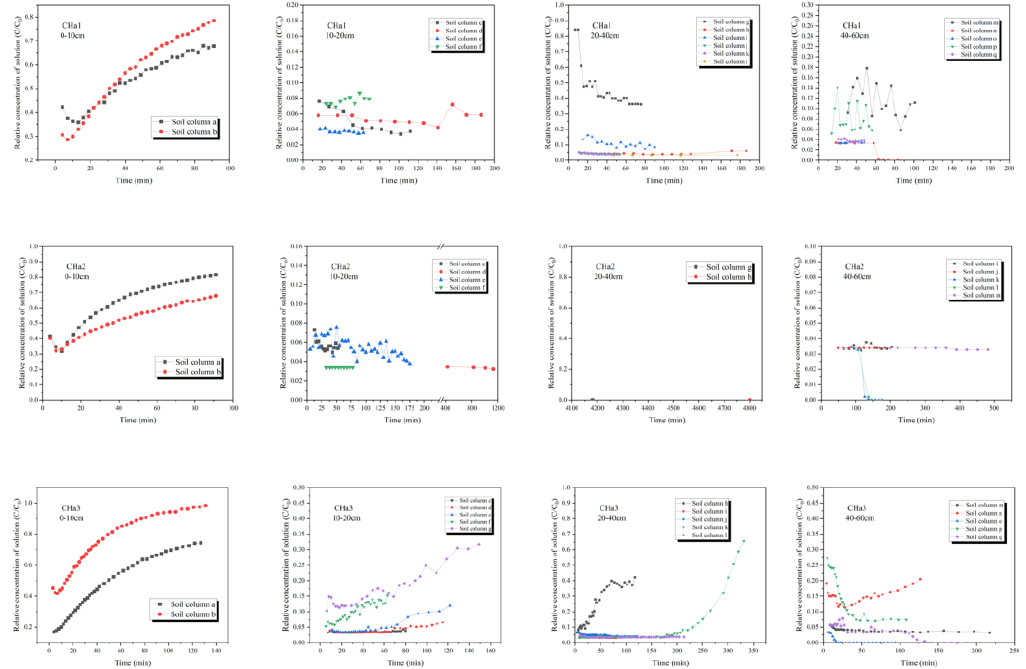
Figure 3. Changes in the relative concentration of a solution of different soil depths with time.